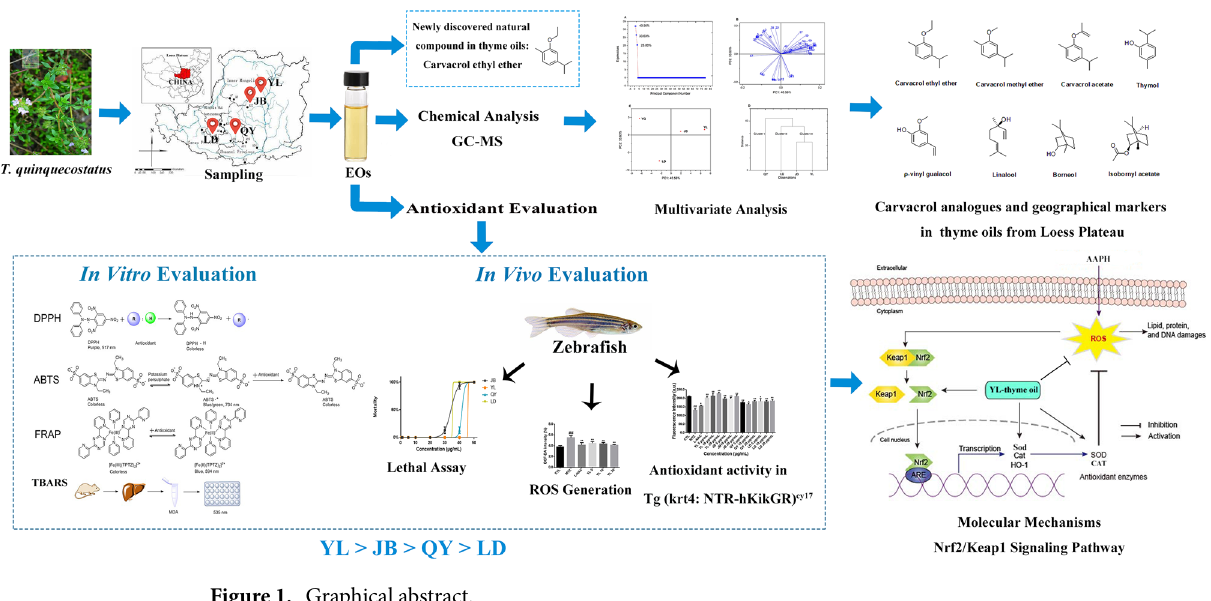
Figure 1. Graphical